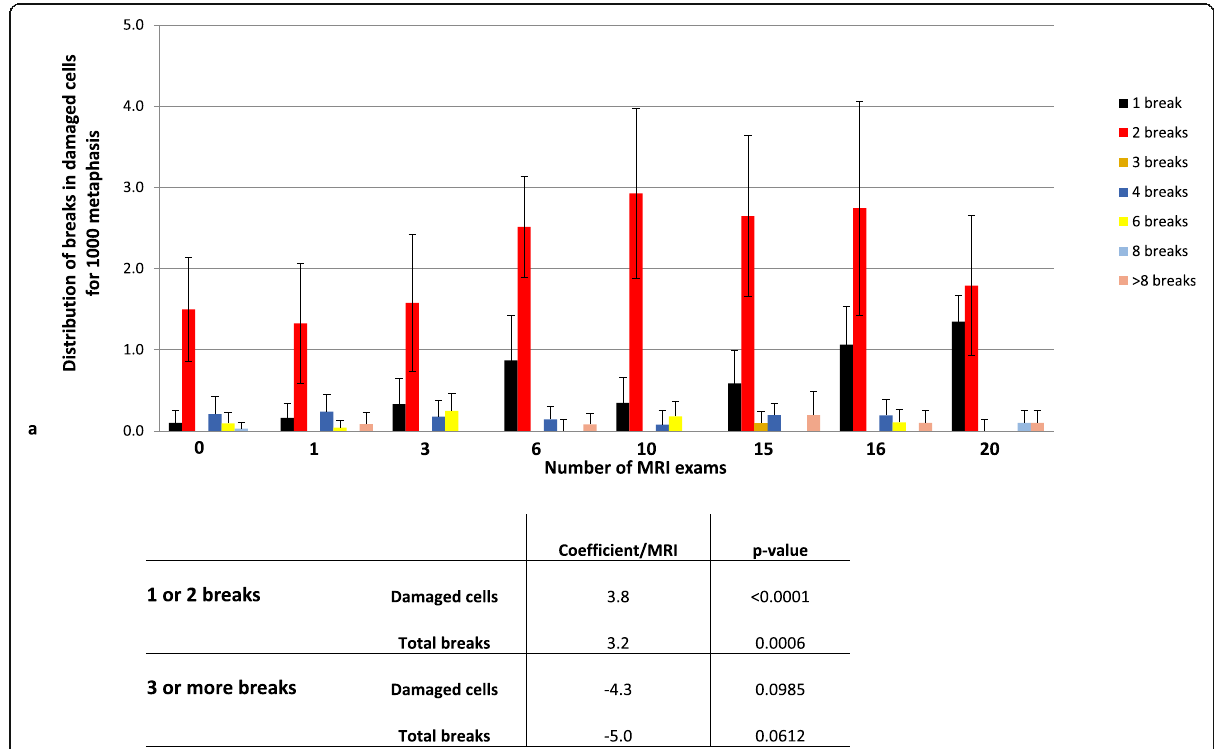
Fig. 3 Distribution of deoxyribonucleic acid breaks in damaged cells. a Only the data for damaged cells are shown and are clustered according to the number of breaks scored. In this graph, all damaged cells are considered, including rogue cells. b Statistical analysis of the damaged-cell phenotype. Cells with one or two breaks were separated from those with three or more breaks. The correlation between the number of MRI sessions and the breaks was calculated for both groups. The statistical analysis shows a strong correlation between the number of MRI sessions and the apparition of cells with few (one or two) breaks. However, there was no correlation between the number of MRI sessions and the number of cells with three or more chromosome breaks. MRI , Magnetic resonance imaging